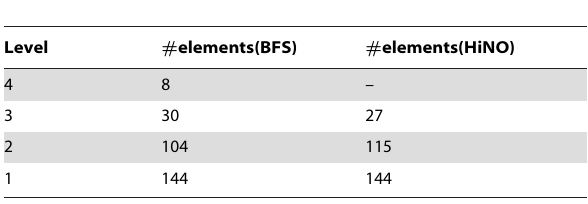
Table 4. Level distribution of the TRN in S. cerevisiae.